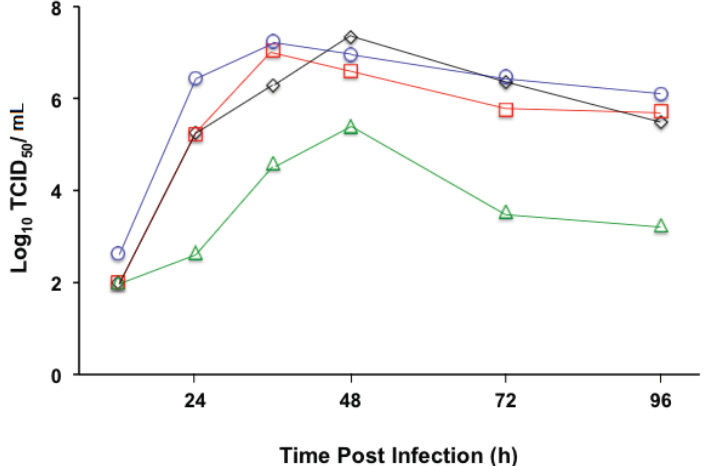
Figure 2. Time course of cell-associated MV production in Vero/hSLAM cells infected with four recombinant viruses: MVvac2 (diamonds, black line), MVvac2(HBsAg)N (squares, red line), MVvac2 (DIII-S)N (circles, blue line), and MVvac2(DIII-S,S)P (triangles, green line). Viral titers (expressed as the log 10 TCID 50 /mL) indicated on the vertical axes were measured 12, 24, 36, 48, 72, or 96 h post infection. Averages of three independent experiments conducted separately are indicated. For clarity, standard deviations of the mean are not